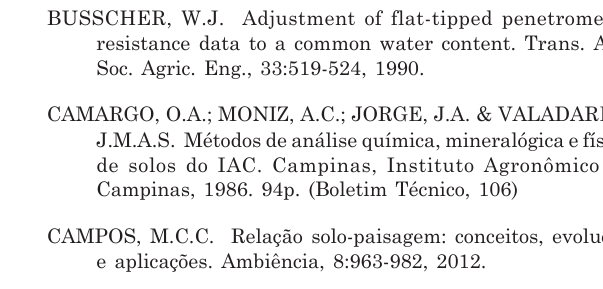
Figura 3. Difratogramas de raios-X de argilas desferrificadas de três perfis: Perfil 1 (a); Perfil 2 (b); e Perfil 3 (c). Reflexos 020, 003 e 131 de